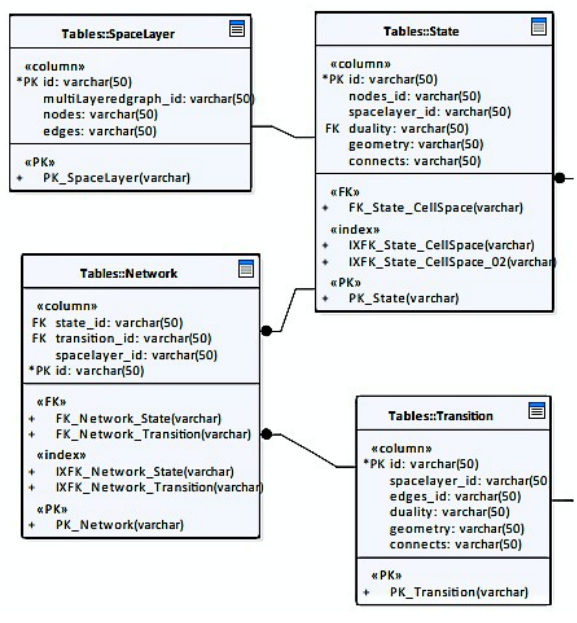
Figure 8. The part of the schema in